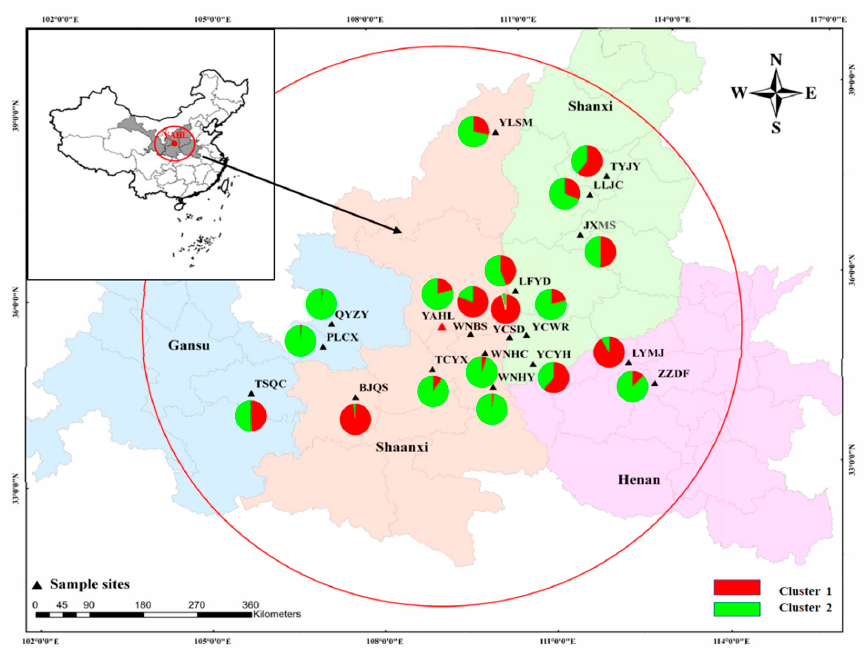
Figure 1. Distribution of the ancient P. orientalis population in the middle reaches of the Yellow River. The triangular points represent the locations of the sample collection sites. The four colors in the image represent four different provinces in China. The sector map represents the distribution of dependency coefficients within 19 ancient P. orientalis populations (k = 2). Table 1. Sampling Locations for the 19 ancient P. orientalis populations.